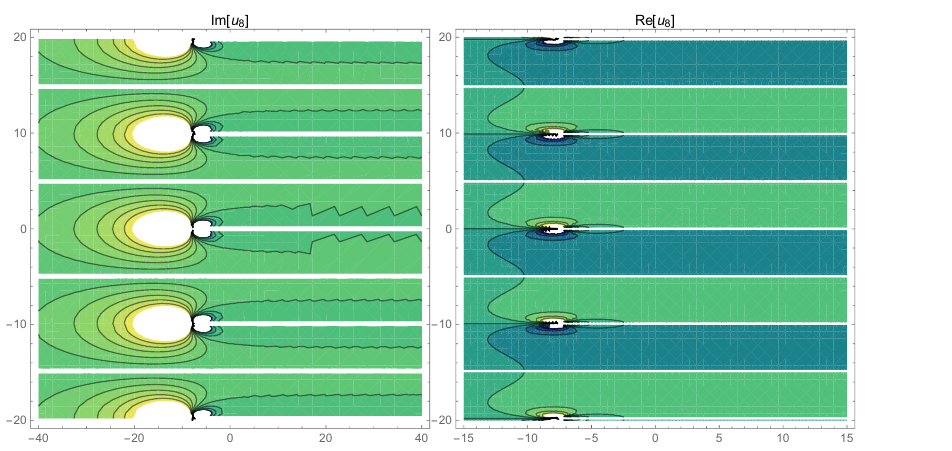
Figure 15. The 3D figures of Equation (21).